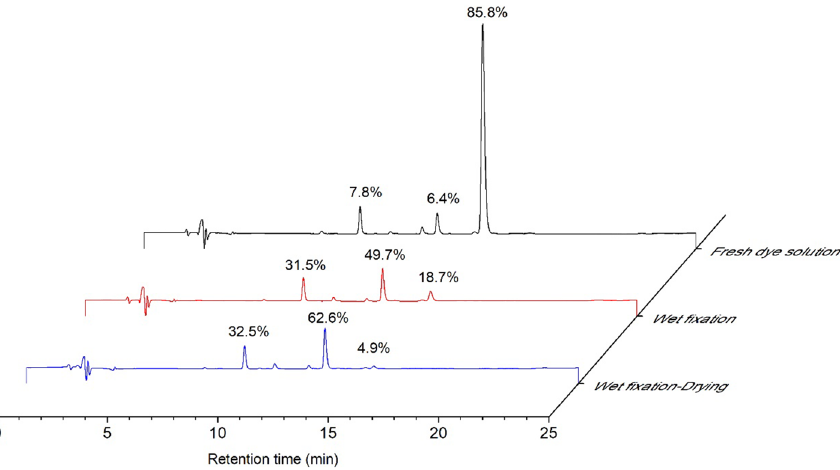
Figure 10. HPLC chromatograms of the Red 2 dye after wet fixation and wet fixation-drying